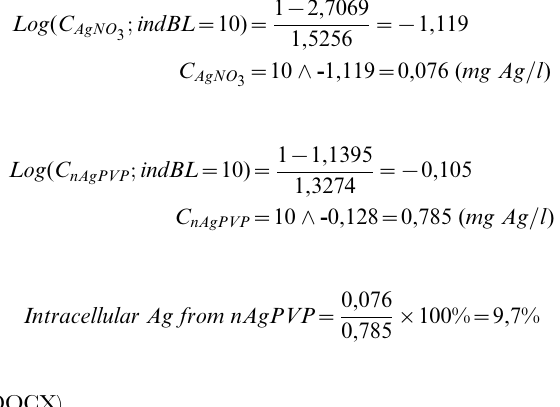
Figure S1 Number and share of articles on silver nanoparticles for six bacterial species in ISI WoS. Keywords used for the search and respective number of retrieved papers were as follows: ‘silver nanoparticles’ and ‘Escherichia coli’ (1162 papers); ‘silver nanoparticles’ and ‘Staphylococcus aureus’ (554 papers), ‘silver nanoparticles’ and ‘Pseudomonas aeruginosa’ (184 papers); ‘silver nanoparticles’ and ‘Bacillus subtilis’ (114 papers); ‘silver nanoparticles’ and ‘Pseudomonas putida’ (11 papers); ‘silver nanoparticles’ and ‘Pseudomonas fluorescens’ (10 papers). Total: 2035 papers. Search made: 06.12.2012. Figure S2 Primary size distribution of silver nanopar- ticles. A: PVP-coated nAg-PVP, B: protein-coated nAg-Col and C: uncoated nAg. Sizes of the silver nanoparticles were measured from TEM micrographs (Figure 1); altogether 65 particles were measured. Figure S3 Response of Ag-biosensor to silver formula- tions. Representative calibration curves of Ag-biosensor Esche- richia coli MC1061 (pSLcueR/pDNPcopAlux) for AgNO 3 (A–C), nAg-PVP (A), nAg-Col (B) and nAg (C) are shown. The lines represent the calibration plots for the linear regression between log(C) 2 log(indBL), whereas C is concentration of Ag (mg/l) in the samples and indBL is a fold induction of bioluminescence in Ag- biosensor in response to intracellular Ag. Linear range of the regression and regression equations are shown. Intracellular Ag was determined by using the linear regression equation for AgNO 3 , which was considered 100% bioavailable and was used as PLOS ONE |